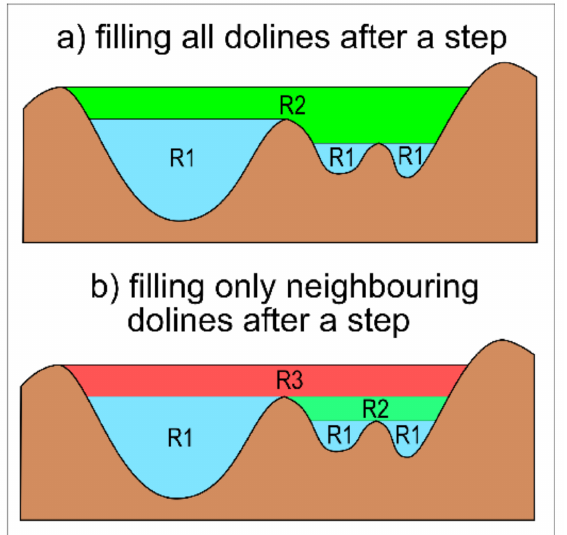
Figure 2. The effect of filling on feature delineation. In case of filling all R1 depressions, the next step would result the large R2 doline according to the upper image. If only the neighboring depressions are filled in one step, then the smaller compound feature, R2 in the bottom image, is also detected. The second option is